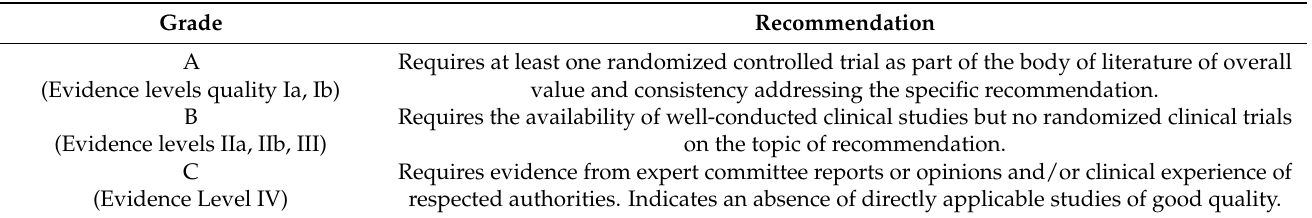
Table 3. General Guidelines for Methodologies on Research and Evaluation of Traditional Medicine